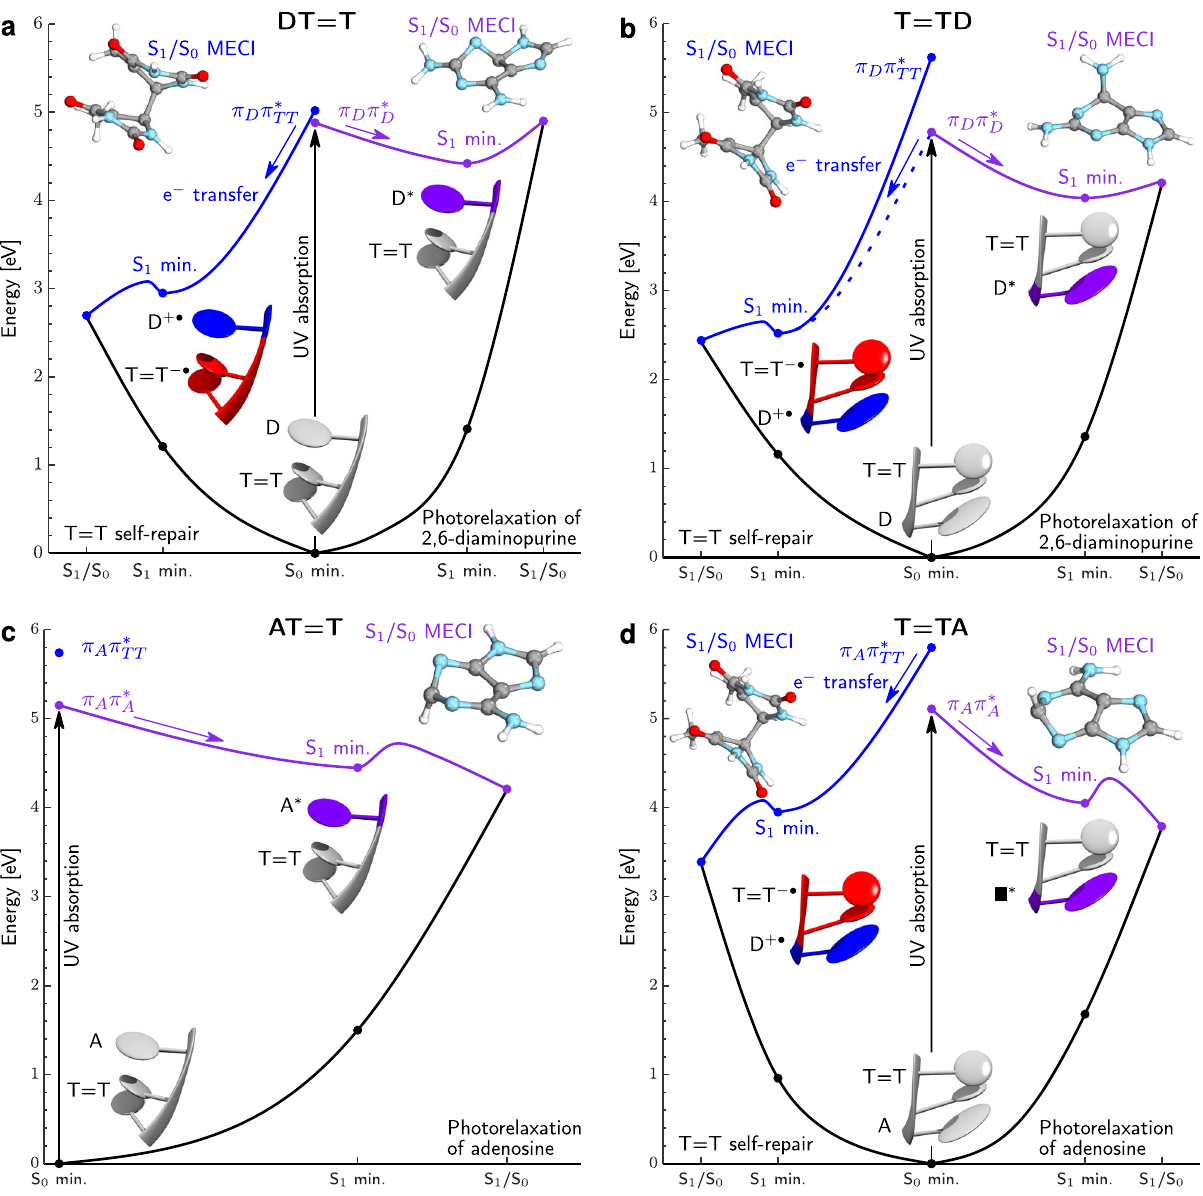
Fig. 4 Potential energy pro fi les calculated with the QM bases /MM approach for the key photorelaxation mechanisms of all four studied trinucleotides. a Blue curve corresponds to self-repair of the T = T dimer triggered by the electron transfer from D. The C5 – C5 bond is broken in the D • + T = T • − /S 0 state crossing. Direct photorelaxation of D base for DT = T – purple curve. Self-repair is the energetically more favorable process. b Analogous photorelaxation channels in T = TD. Dashed blue line indicates mixing between the T = T • − D • + and T = TD* states. c The T = T • − A • + con fi guration is not energetically available in the S 1 state and only the direct photorelaxation of A is presented. d High adiabatic excitation energy of the repairing A • + T = T • − state results in dominant role of direct photorelaxation of A in AT = T. The electronic-structure (QM) calculations were performed at the ADC(2) and MP2 levels with the TZVP basis set. The molecular structures depict the key structural changes for purine bases or the T = T in the S 1 /S 0 minimum-energy conical intersection (MECI). Table 1 Electron transfer rate constants and the corresponding timescales of electron transfer from the purine base to the T = T CPD estimated for three of the studied